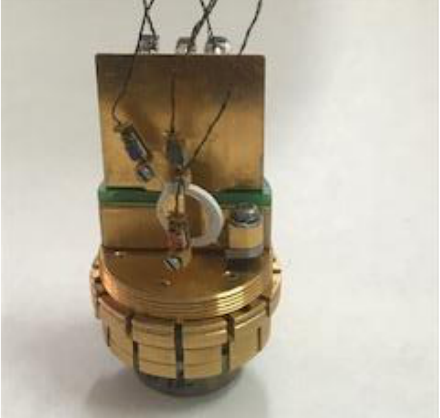
Figure 1. Sample assembled in the PPMS.